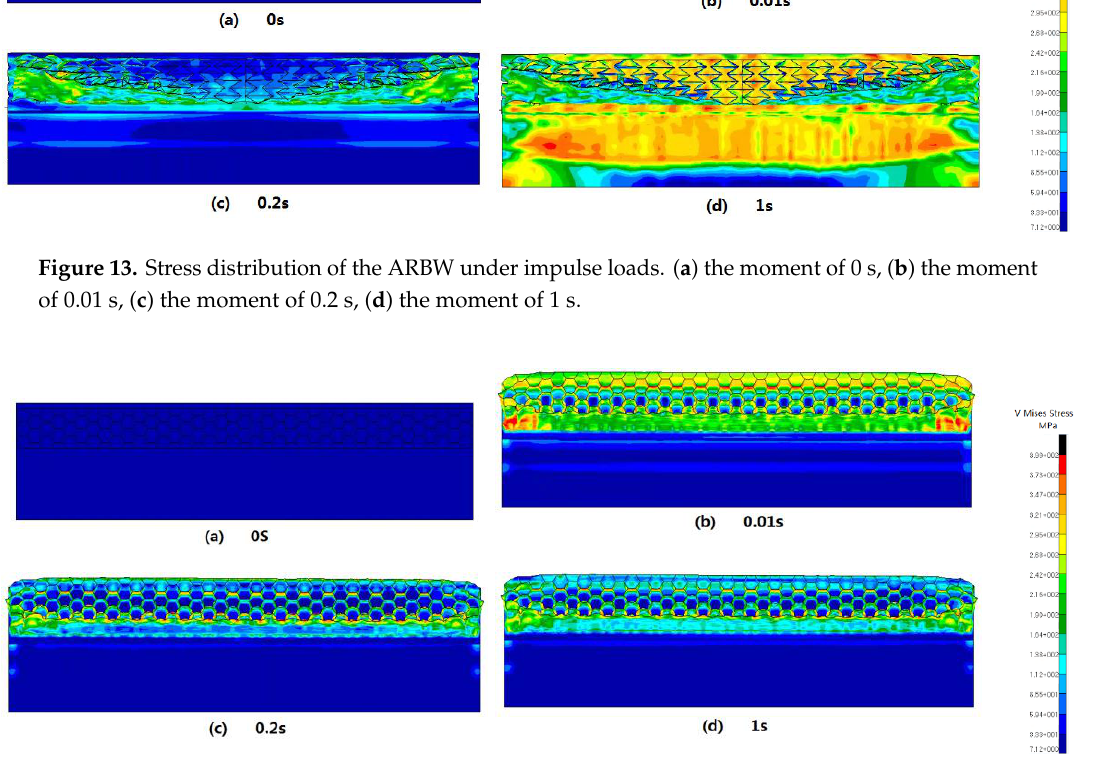
Figure 14. Stress distribution of the HSBW under impulse loads. ( a ) the moment of 0 s, ( b ) the moment of 0.01 s, ( c ) the moment of 0.2 s, ( d ) the moment of 1 s.